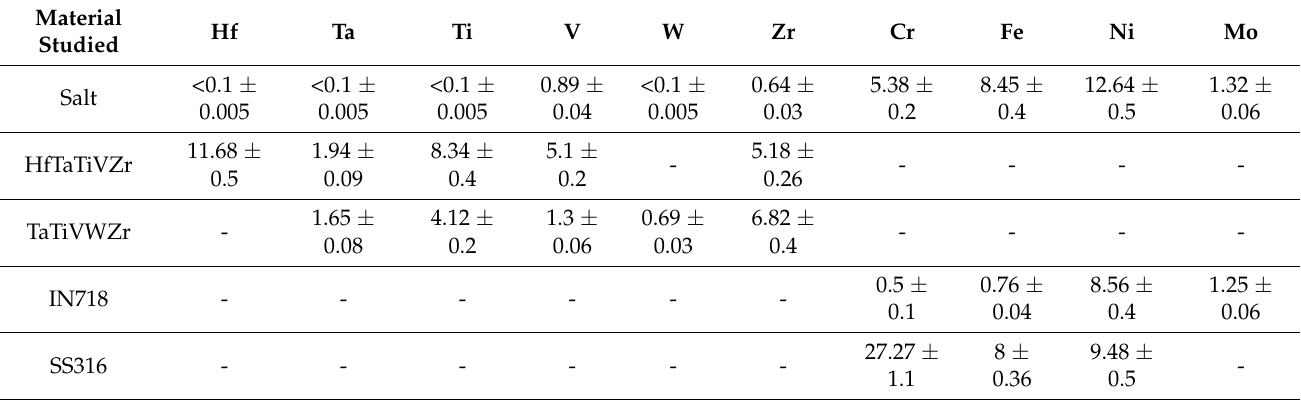
Table 3. Dissolved metal concentration (in ppm) determined by ICP-OES after corrosion test at 650 ◦ C with reference to the salt before the corrosion test (i.e., immediately following salt pre-conditioning); error ±